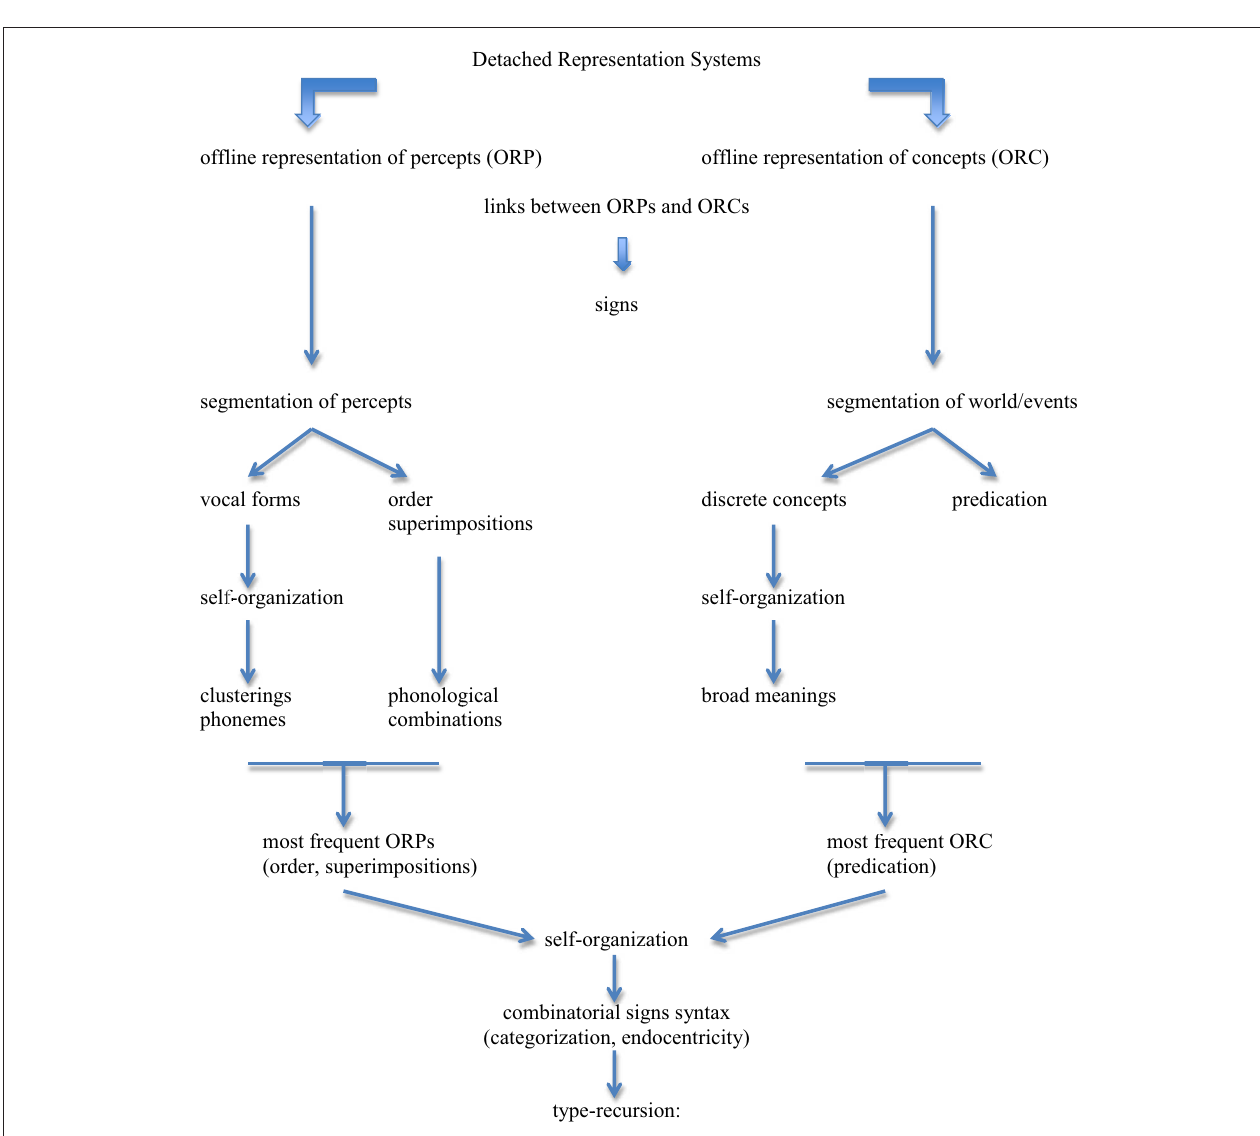
FIGURE 3 | General outline of the model. Detached Representation Systems produce offline representations of percepts (ORP) and offline representations of concepts (ORC). Links between ORPs and ORCs create linguistic signs. These signs have restricted traits because the prior properties of the substances of percepts and concepts severely constrain them. The segmentation of percepts produces a potentially infinite set of vocal forms; these forms undergo self-organization that creates clusterings that result from frequency and accumulation due to ease of production and distinctness of perception: this delimits the set of potential phonemes for languages. The segmentation of percepts also introduces order and superimposition (intonation, length, stress), which derive phonological combinations. The segmentation of world/events produces a potentially infinite set of discrete concepts; these concepts undergo self-organization that creates clusterings that result from frequency and accumulation due to relevance/usefulness for the organism: this delimits the set of broad meanings for languages. Concepts fall in two broad classes, objects and properties, the latter introducing the notion of predication in a broad sense. The most frequent ORP elements are order and superimposition, and the most frequent ORC element is predication. These accumulation points are so overwhelmingly dominant in their respective domains that they increase the frequency of links involving them to the point where these links inevitably develop into combinatorial signs (syntax). Given categorization and endocentricity (due to object permanence), the syntax of languages has the formal property of